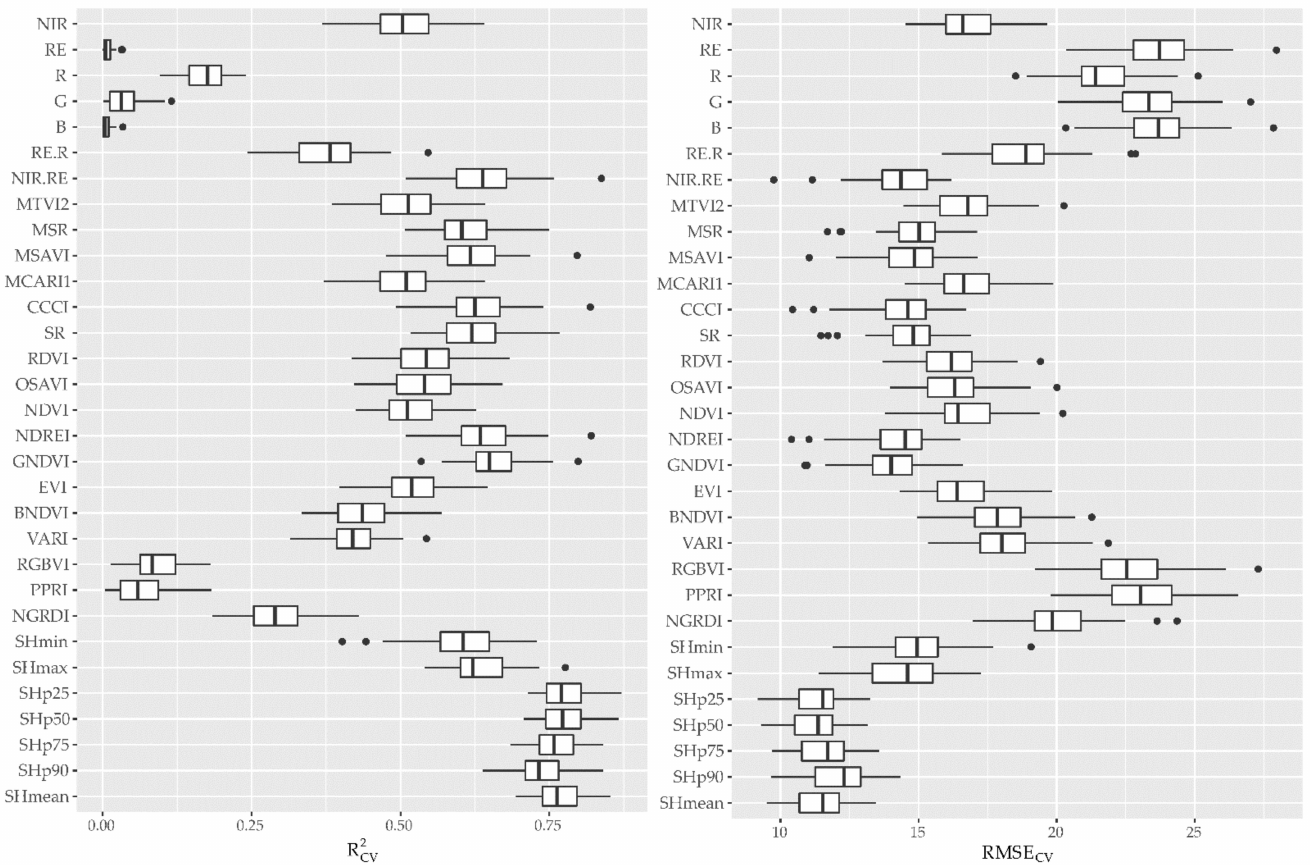
Figure 17. Box and whisker plot of R 2 CV and RMSE CV (kg ha − 1 ) of all resamples of linear models (simple linear regression) for N-uptake